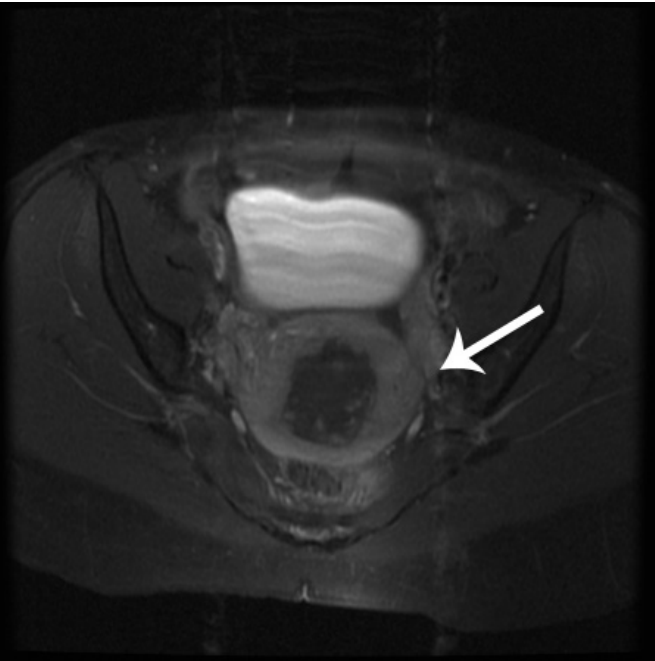
Figure 3 . Magnetic resonance imaging of uterus in transverse axis demonstrating amorphous collection of vessels with fluid in the endometrial